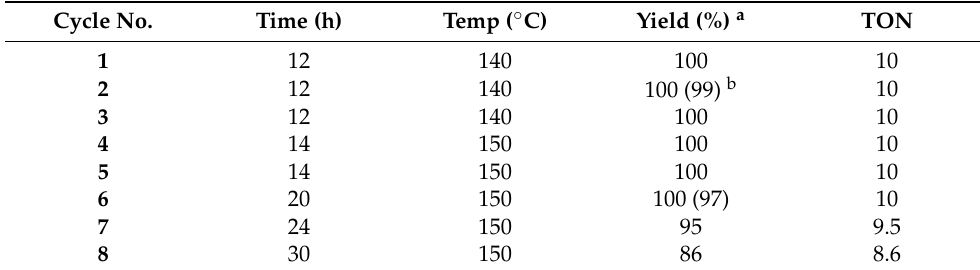
Scheme 3. The Pd catalyst ( 2a )-catalyzed Stille reaction of aryl bromides ( 8–10 ) with vinyl tributyltin ( 3 ) under the thermomorphic condition. Table 5. Recycling result of 2a -catalyzed Stille reaction of bromobenzene ( 8 ) and vinyl tributyltin ( 3 ) under the thermomorphic mode.